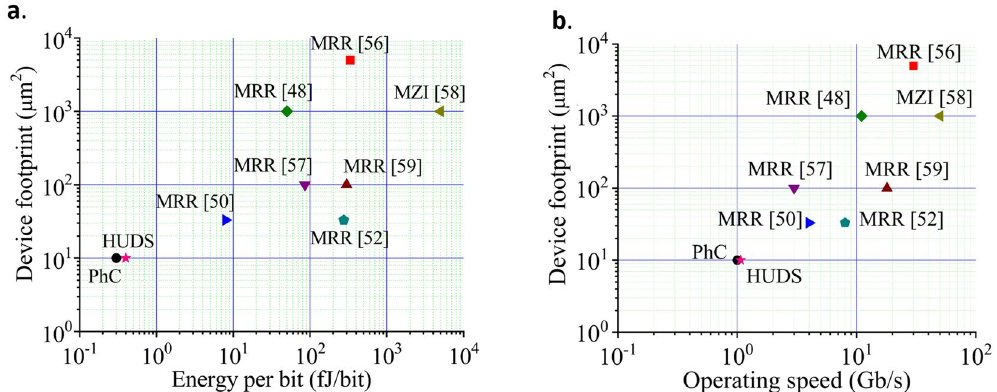
Figure 8. Device footprint as a function of ( a ) energy per bit and ( b ) operating speed for state-of-the-art silicon optical modulators. HUDS-based modulator (red star) and photonic crystal-based modulator (black circle) designs share with photonic crystal modulators the same orders of magnitude improvement in compactness and energy efficiency as compared to modulators based on MRRs and